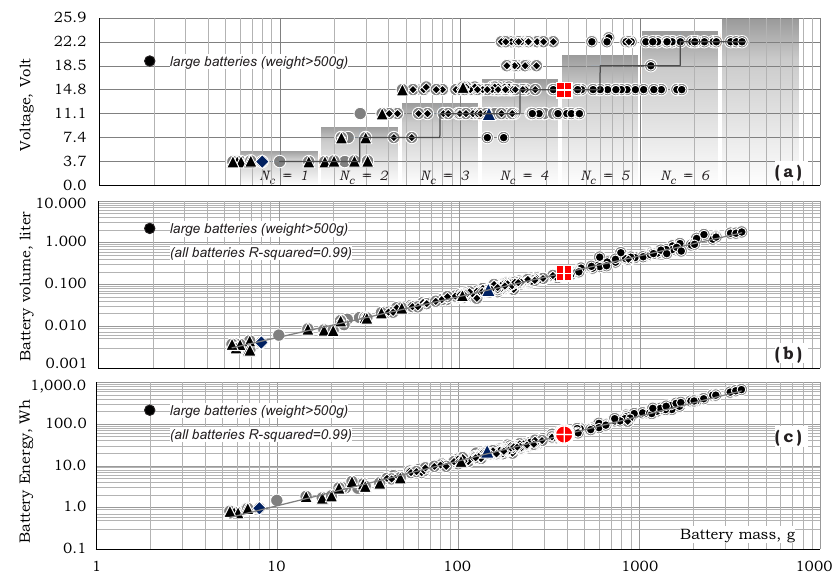
Figure 13. Battery parameters design trends, [17,18,23]. Battery voltage (essentially 3.7 N c Volt where N c is the number of 3.7 Volt cells),